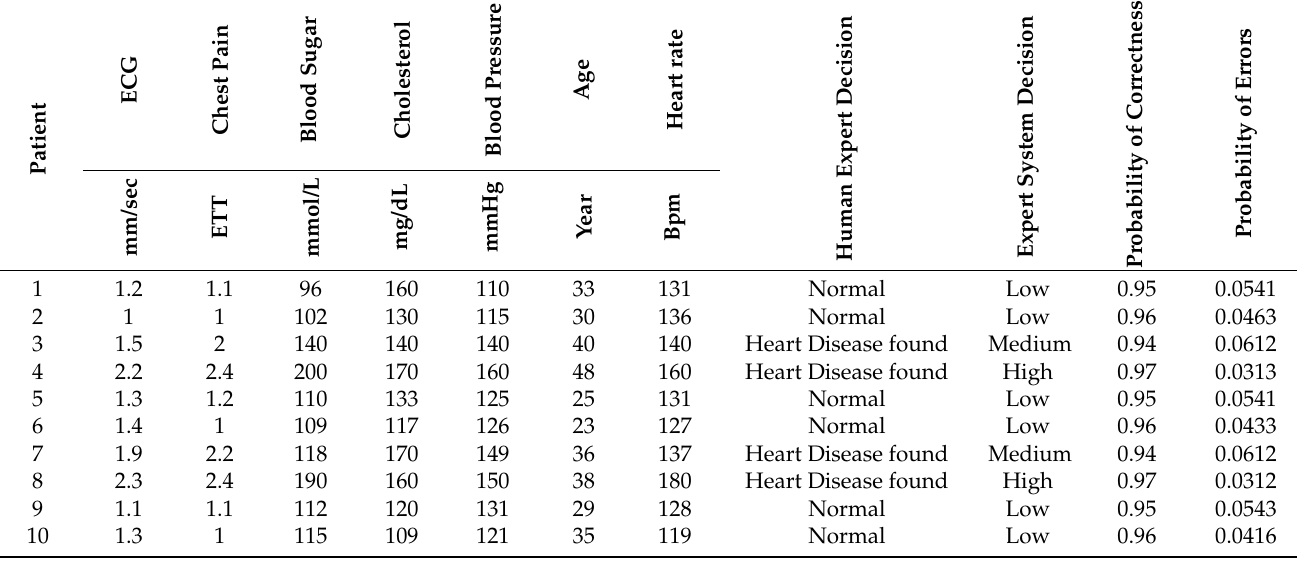
Table 2. Test results and expert